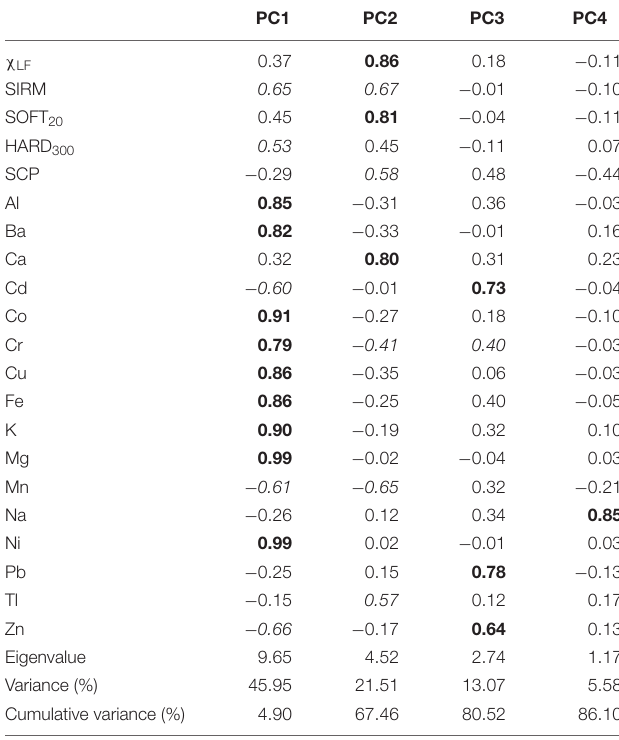
TABLE 4 | Principle component analysis (PCA) for SKP1 showing loadings of variables on the principle components (PC), eigenvalues, the percentage of variance of total sample explained by the PC and cumulative